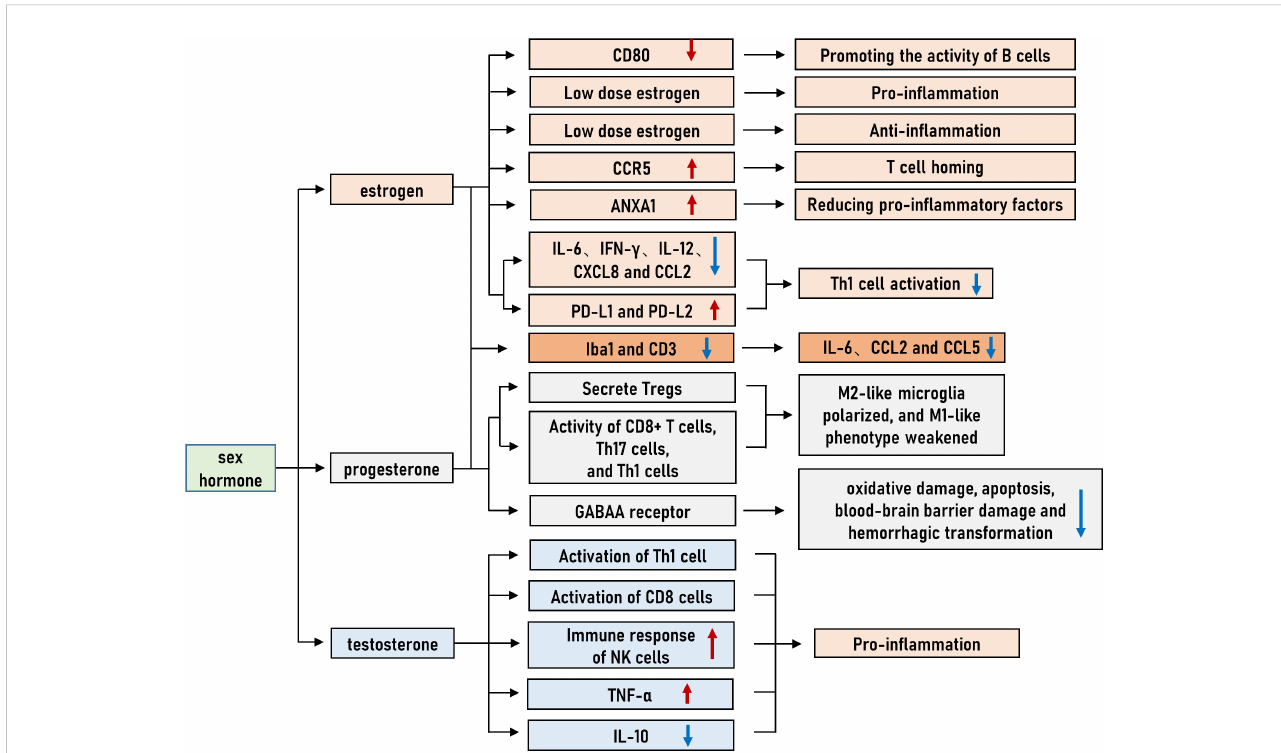
FIGURE 1 Sex difference in immunity. Estrogen, progesterone and testosterone regulate immune tendency by regulating immune cell function and cytokine